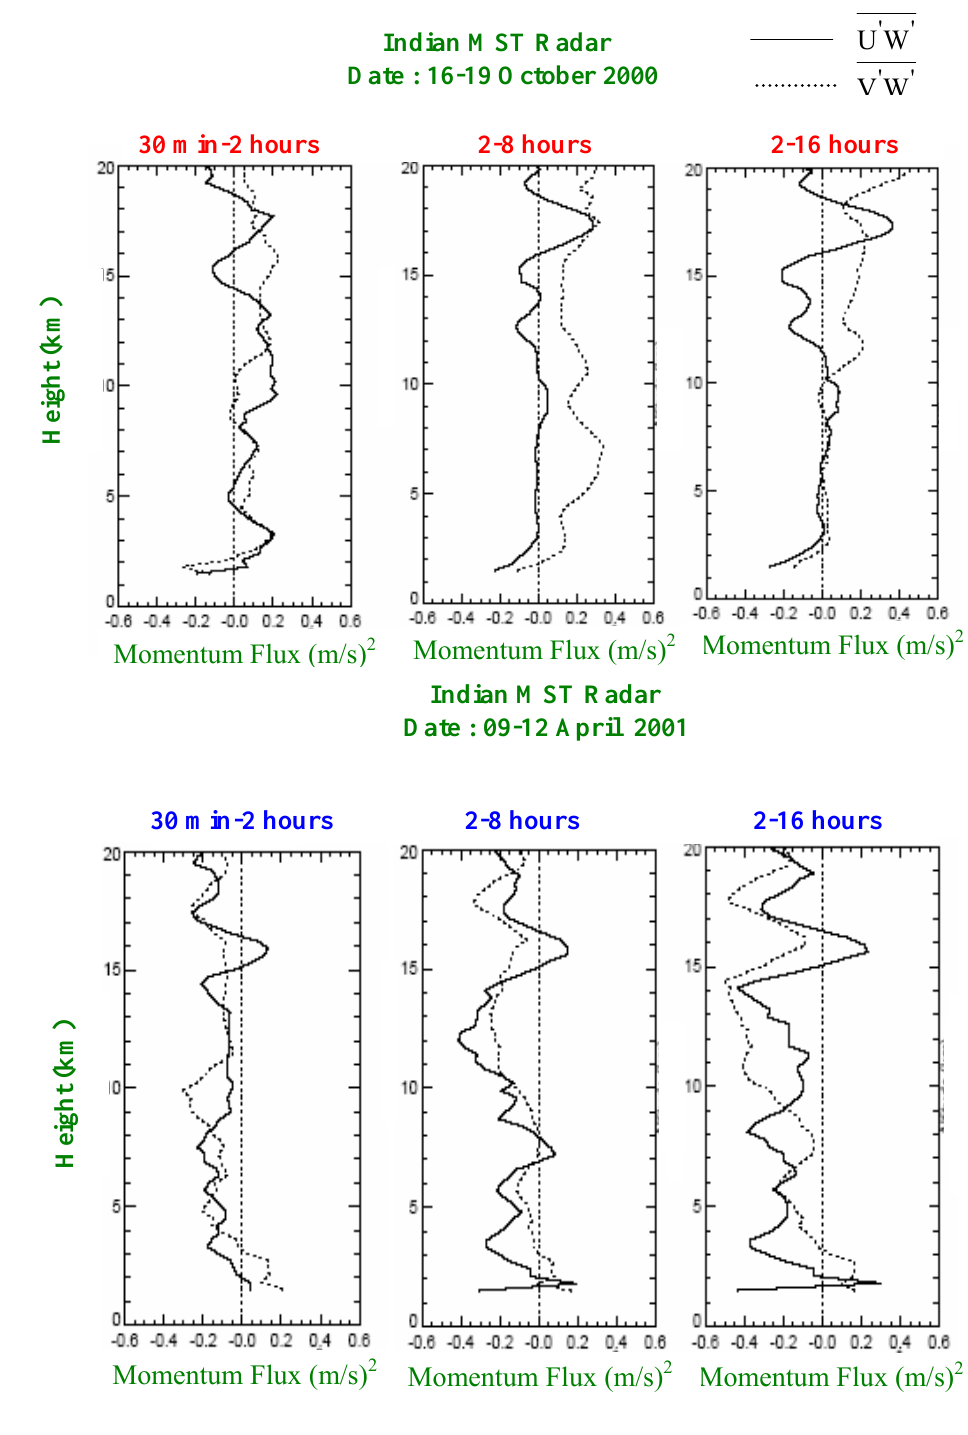
Fig. 15. Vertical profiles of zonal and meridional momentum fluxes estimated from the four beam method for different frequency bands (30min–2h, 2–8h, 2–16h) during 16–19 October 2000 (upper panel) and 9–12 April 2001 (lower panel). The solid line represents the zonal momentum flux and the dotted line represents the meridional momentum flux.